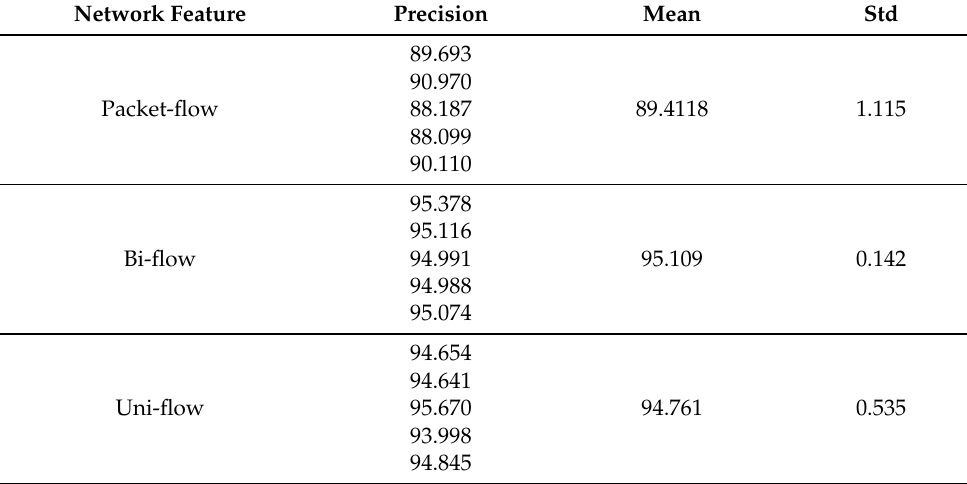
Table 14. Multi-class attacks classification results in term of precision.